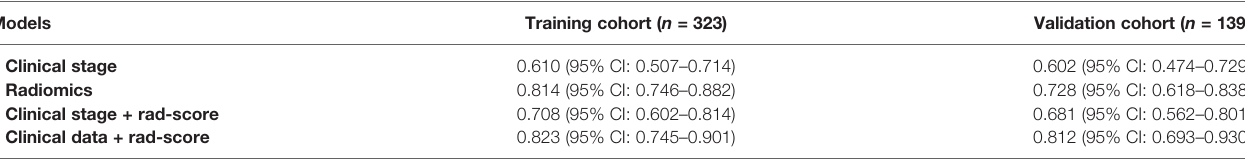
TABLE 3 | C-indexes of the four models.